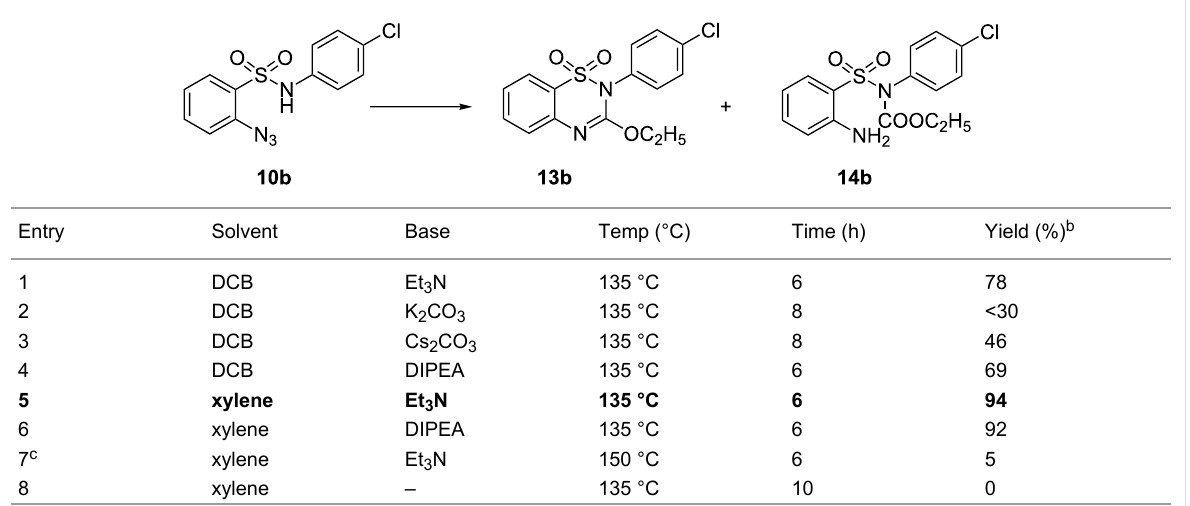
It is notable that xylene appears to be a suitable solvent for this reaction. We then carried out the reactions with a variety of